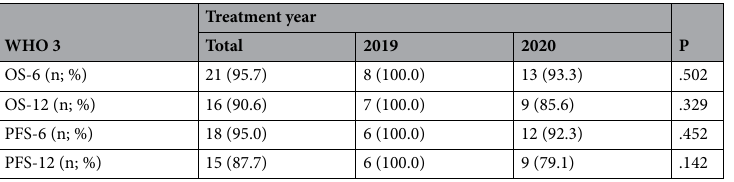
Table 2. Overall survival and progression-free survival at 6 and 12 months compared between the 2019 and 2020 cohorts of Patients with WHO Grade 3 gliomas according to Kaplan–Meier estimation. OS—overall survival, PFS—progression-free survival,